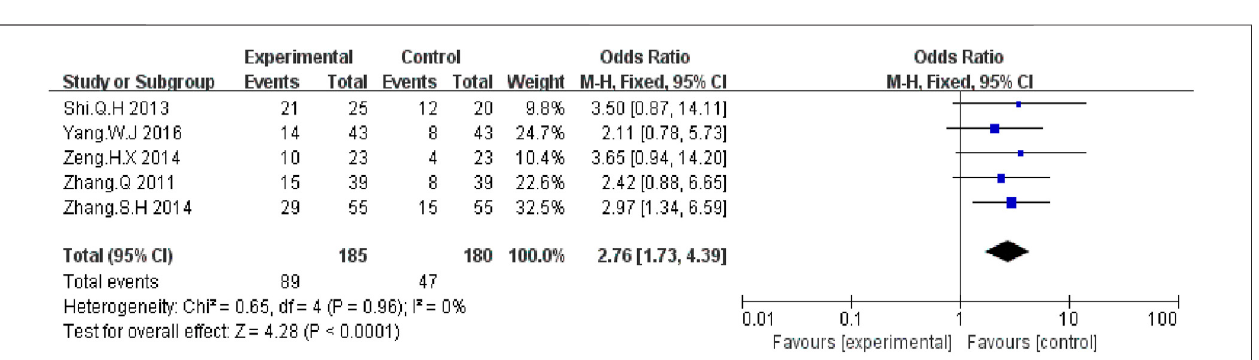
Frontiers in Pharmacology |